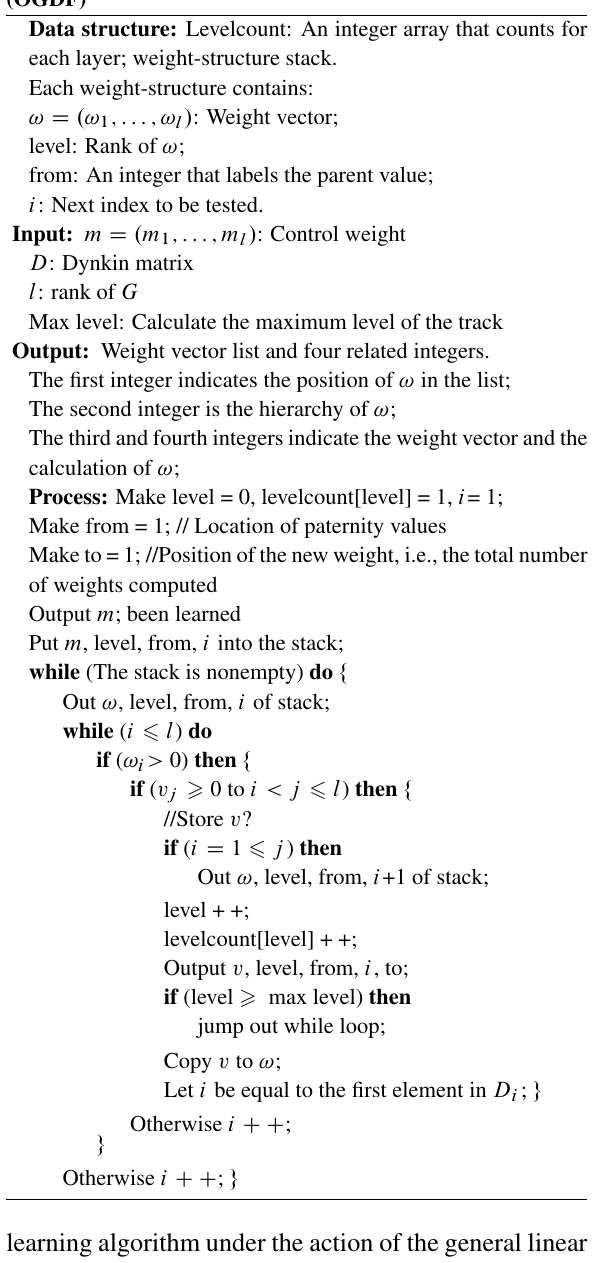
Orbit Generation Depth-First